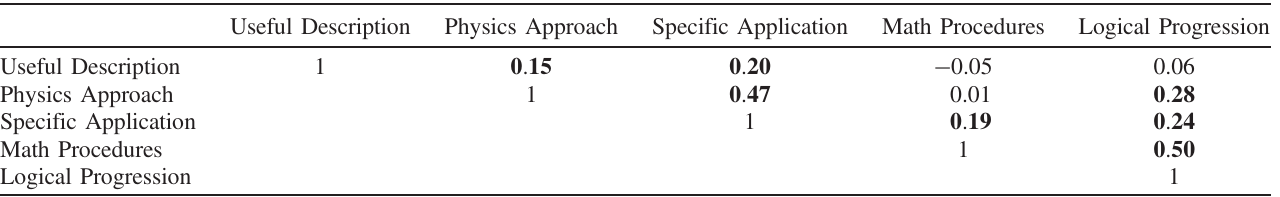
TABLE IV. Intercategory correlation coefficients ρ between rubric category scores for eight midterm problems from two introductory physics sections ( N ¼ 918 ). Correlations in bold are statistically significant ( p < 0 . 01